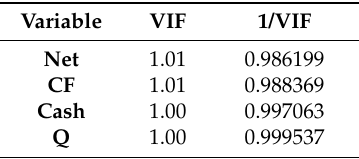
Table 4. Multicollinearity verification in model 2.